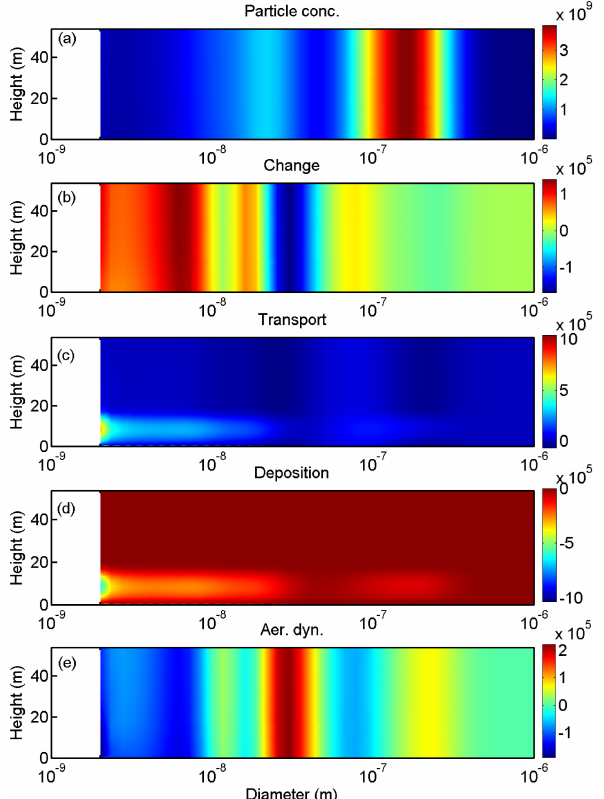
Figure 5. Integrated up to the canopy top conservation equation (Eq. 4) terms for the same periods as in Fig. 3a and b, normalized with the concentration at the canopy